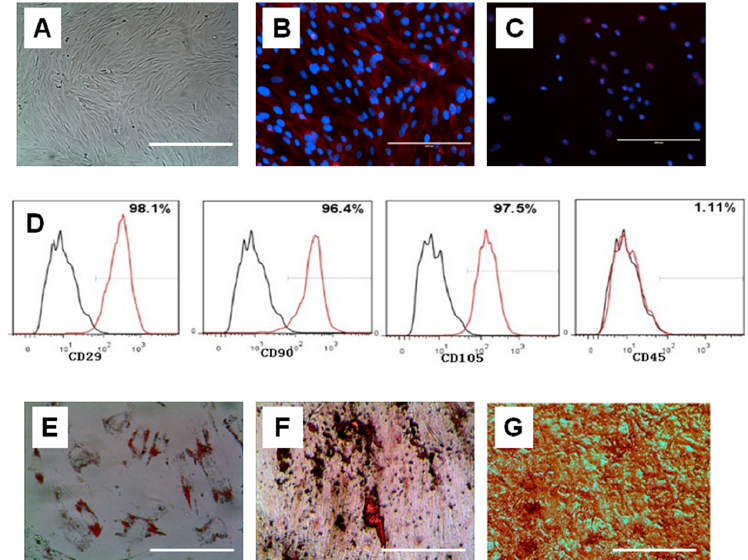
Figure 3. Identification of human amniotic mesenchymal cells (hAMSCs). ( A ) The fibroblast-like morphology of hAMSCs at P3; ( B , C ) hAMSCs were positive for stem cell markers Oct-4; ( B ) and SSEA-4 ( C ); ( D ) Immunophenotypical characterization of hAMSCs. Cells at the 5th culture passage were trypsinized, labeled with antibodies against the antigens indicated and analyzed by flow cytometry. hAMSCs expressed CD29, CD90 and CD105, but did not express CD45. Black, isotype control; red, antibody; ( E – G ) Multi-lineage differentiations of hAMSCs in vitro. hAMSCs were stained with Oil Red O after being induced in adipogenic differentiation medium for 2 weeks ( E ). Small colonies with lipid secretion were clearly seen. hAMSCs were stained with Alizarin red S after being induced in osteogenic differentiation medium for 3 weeks ( F ). hAMSCs were stained Safranin O after being induced in chondrogenic differentiation medium for 3 weeks ( G ). Scale bars, ( A – C ) 200 μ m; ( E – G ) 50 μ